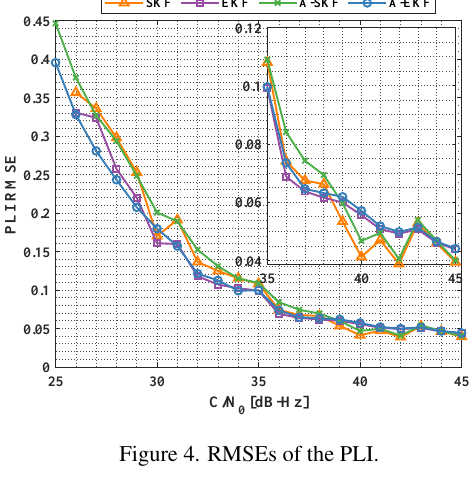
Figure 4. RMSEs of the PLI.